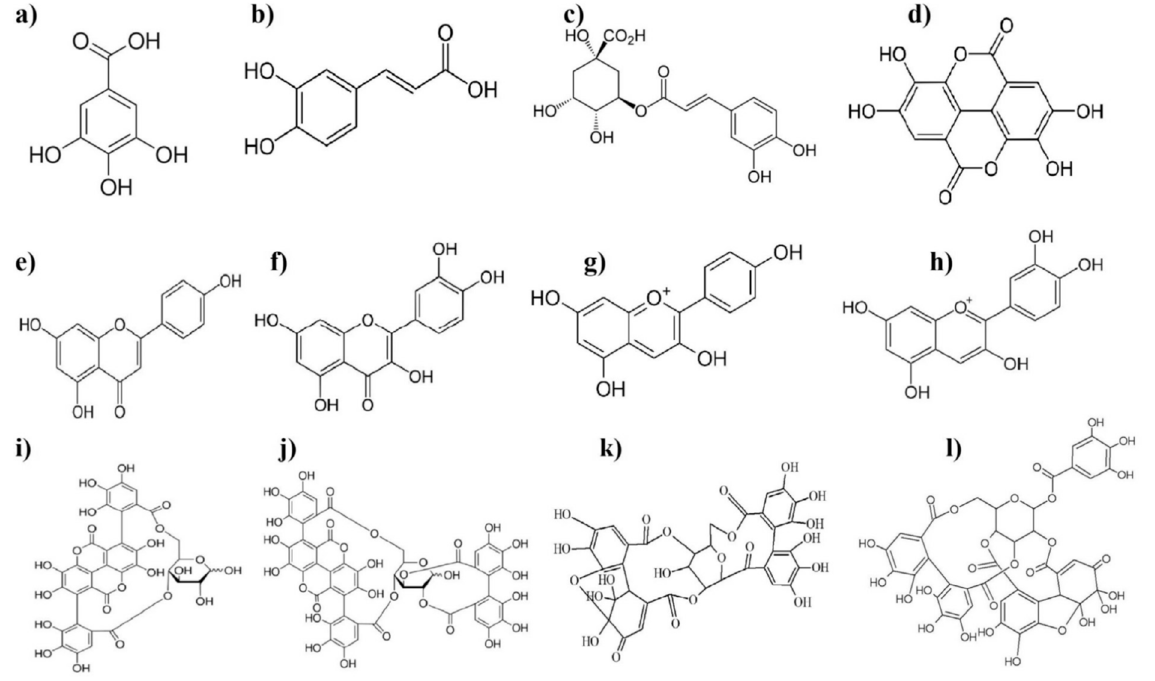
Figure 1. Chemical structure of major phenolic compounds from pomegranate fruit: ( a ) gallic acid, ( b ) caffeic acid, ( c ) chlorogenic acid, ( d ) ellagic acid, ( e ) apigenin, ( f ) quercetin, ( g ) pelargonidin, ( h ) cyanidin, ( i ) punicalin, ( j ) punicalagin, ( k ) granatin A, and ( l ) granatin B. Table 2. Pomegranate plant parts and their chemical